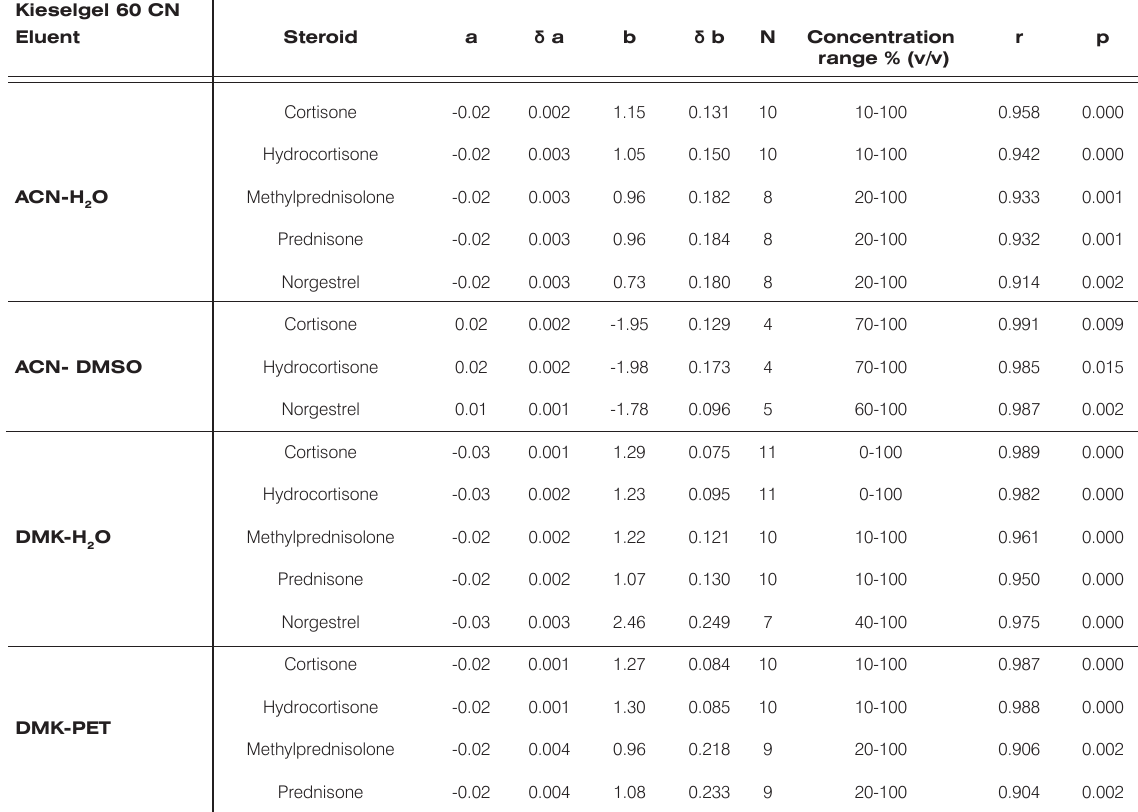
Table 5. Regression coefficients ( a , b ) and correlation coefficient ( r) for the regression equation R p <